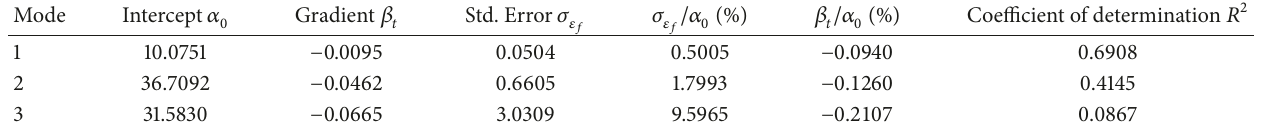
Table 6: Coefficients of linear regression model (frequency ∼ humidity) of girder No. 2.